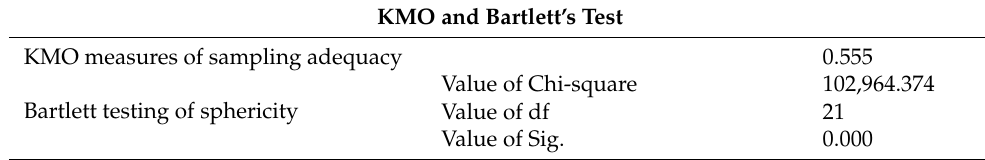
Table 9. KMO and Bartlett test results.